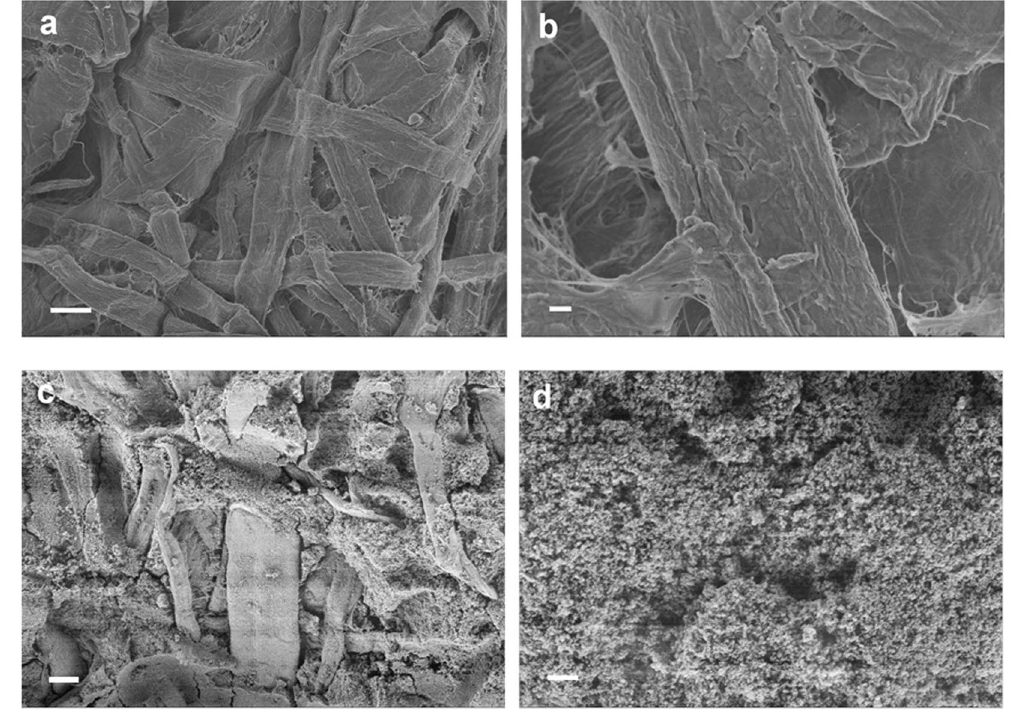
Figure 7. SEM images of the porous membrane PPHM-3 ( a , b ) after ethanol treatment and ( c , d ) after drying under vacuum oven at 80 °C for 12 h. The scale bar is 20 µ m in ( a , c ) and 2 µ m in ( b , d